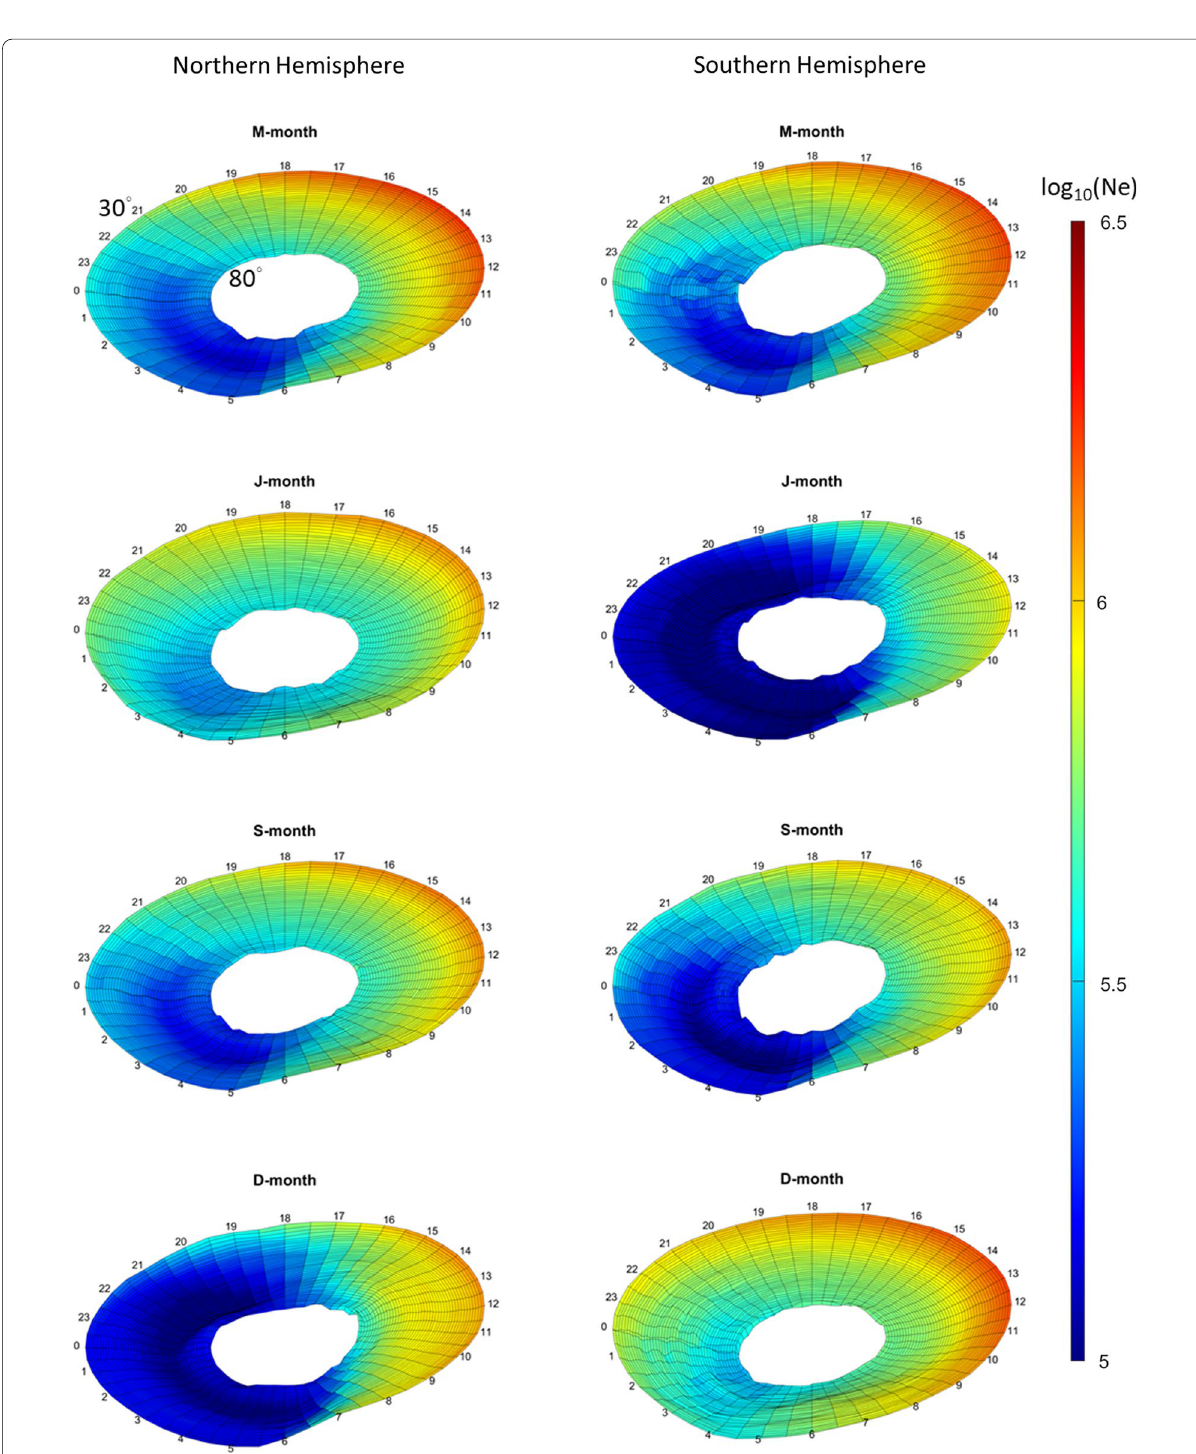
Fig. 5 The seasonal averaged pseudo 3D images of the F2 peak density, NmF2, map from April 2006 to April 2019 in magnetic polar coordinates for the March equinox (M‑month), June solstice (J‑month), September equinox (S‑month), and December solstice (D‑month). The inner and outer perimeters are 80° and 30° in magnetic latitude. The left and right columns are results in the Northern and Southern hemispheres, respectively. The color and vertical change refer to the electron density, and the numbers around each plot give the geomagnetic local time. Cell: 0.5 MLT Sliding window: 1‑h 5°. MLT: magnetic local time. MLAT: magnetic ×